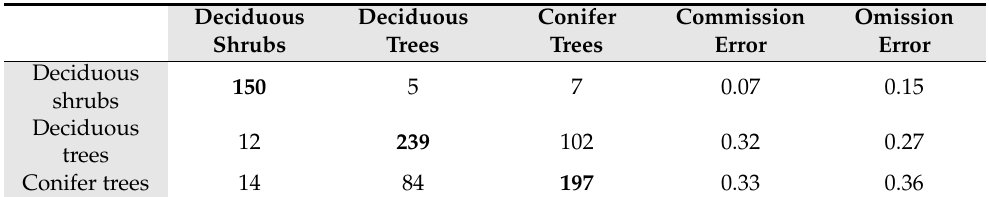
Numbers in bold represents the number of correctly identified groups compared with